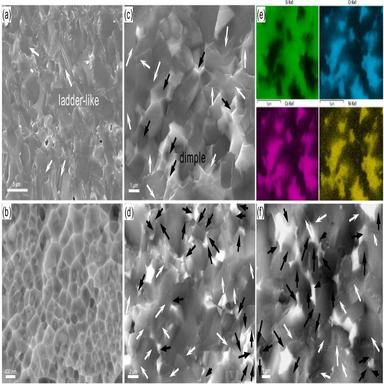
Microstructure of SiC and CCN/SiC composites sintered at 2200 ℃. (a-b) is fracture surfaces of SiC, CCN. (c-d) are fracture surfaces of CCN/SiC-2.5 wt%. (f) is fracture surface of CCN/SiC-7.5 wt%. (e) is the elemental mapping of c.